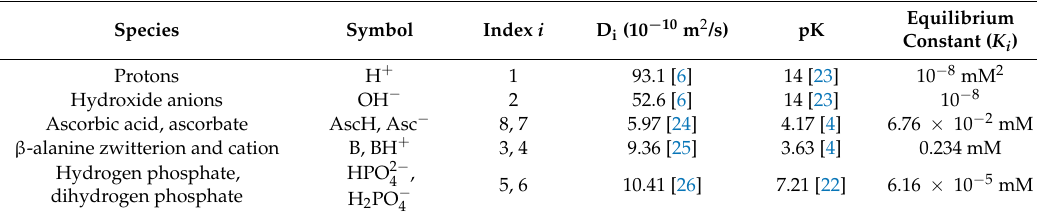
Table 1. Parameters used for the calculation of P from pH profiles that have been induced by the transmembrane AscH flux.